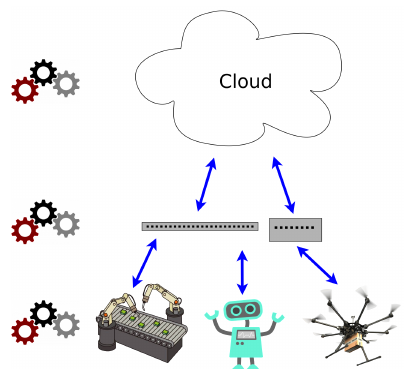
Figure 1. The Dew Robotics